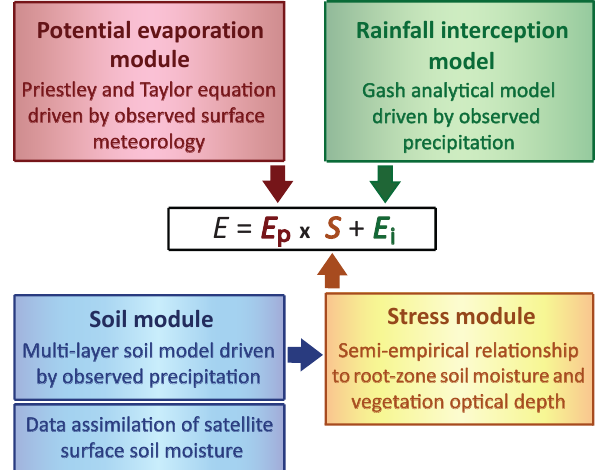
Figure 1. Schematic of the four modules of